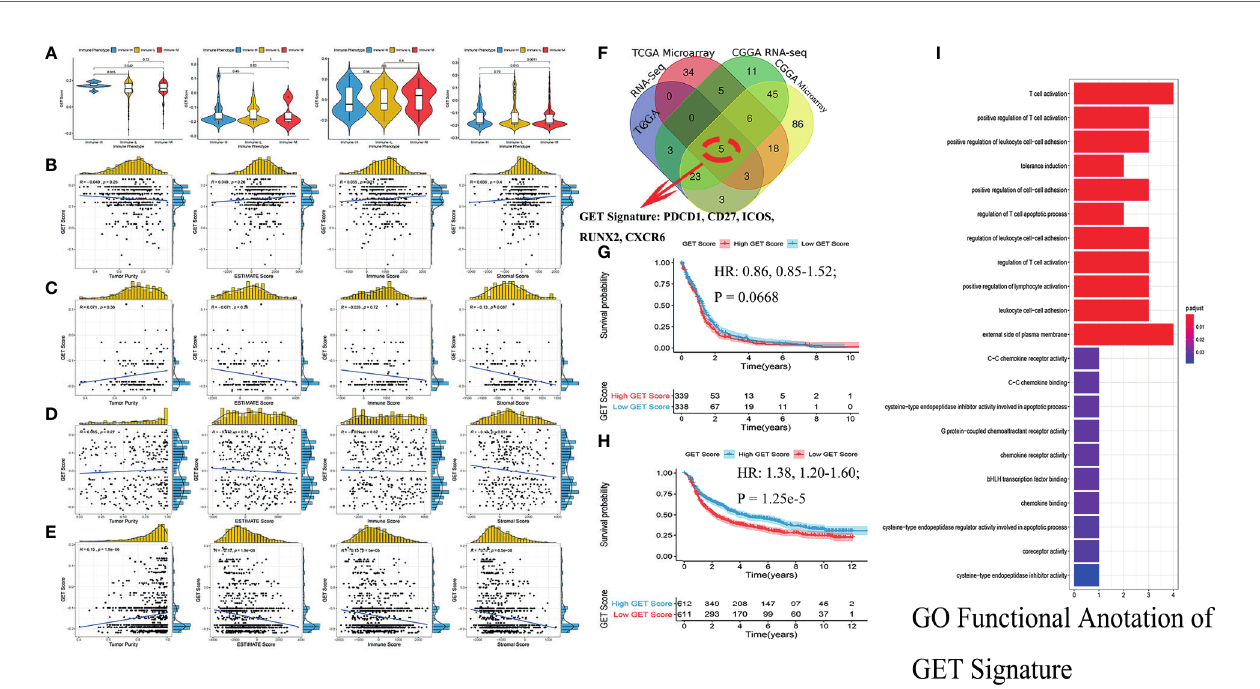
FIGURE 6 | Detection of a gene expression signature of exhausted CD8+ T cells in glioma. (A) Comparisons of GET Score among classi fi ed immune phenotypes in TCGA microarray, TCGA RNA-Seq, CGGA microarray, CGGA RNA-Seq four cohorts. (B – E) The correlation between GET Score and Tumor Purity, ESTIMATE Score, Immune Score and Stromal Score in above four cohorts respectively. (F) Venn diagram exhibited the fi ve selected genes termed as GET Signature (PDCD1, CD27, ICOS, RUNX2, CXCR6). (G, H) Comparison of the prognosis of high GET Score and low GET Score group in total TCGA and CGGA datasets. The cut-off value was de fi ned as the median GET Score of all involved samples. (I) Functional enrichment of GO terms relating to the GET